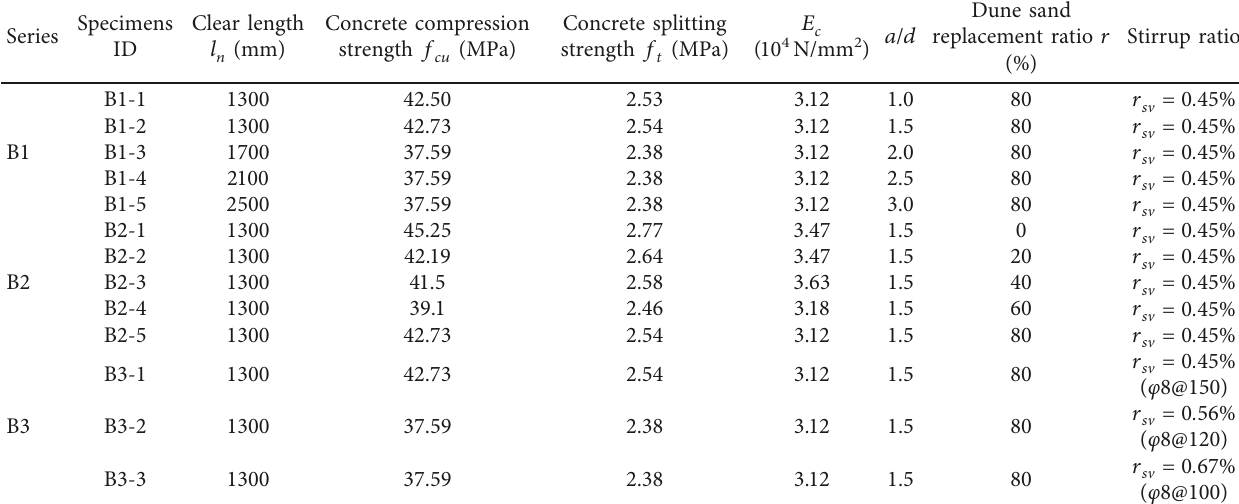
Table 4: Details of the experimental